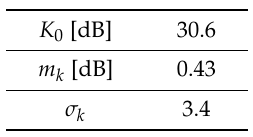
Table 5. Each parameter of the K factor of IEEE model CM